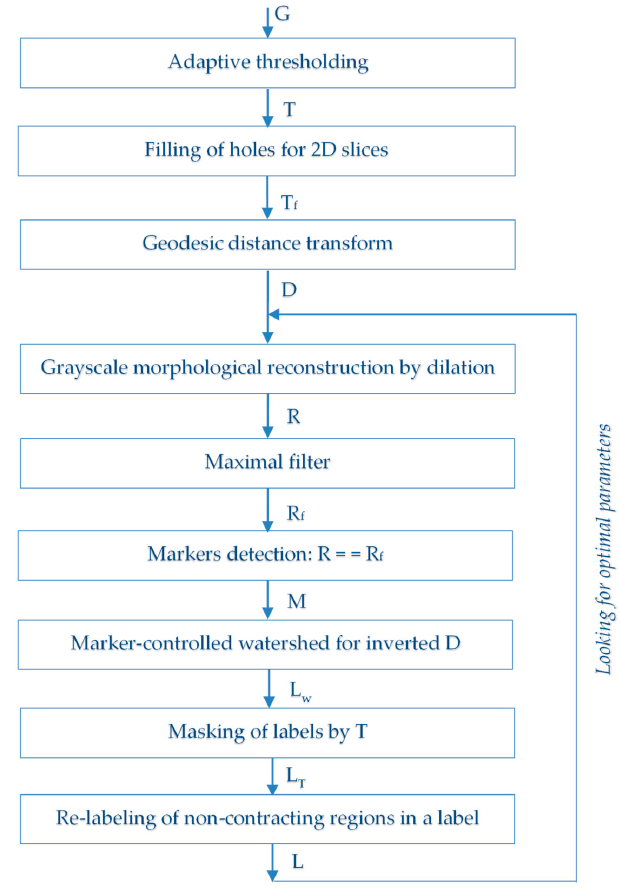
Figure 4. Flow-chart of segmentation procedure.